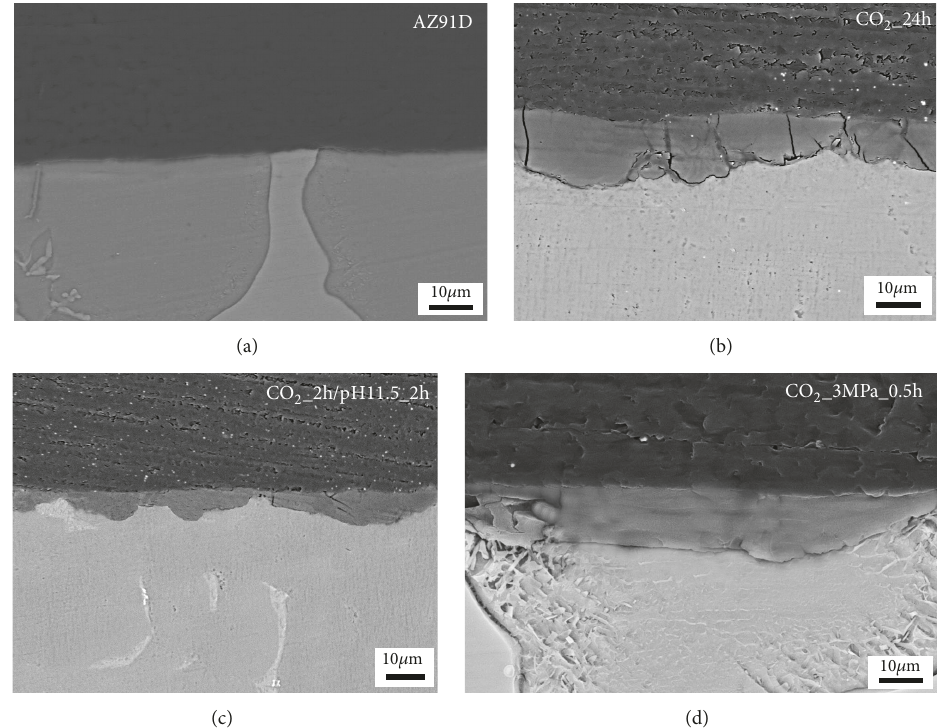
Figure 5: Cross-sectional microstructures of conversion coatings with various processes on AZ91D alloys: (a) unhandled-AZ91D, (b) CO 2 24h, (c) CO 2 2h/pH11.5 2h, and (d) CO 2 3MPa 0.5h.